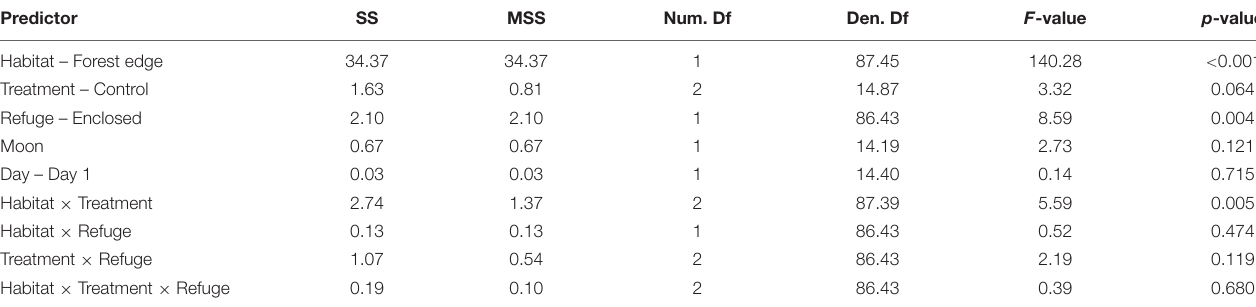
TABLE 1 | Model output showing the effects of habitat, refuge, risk treatment, moon illumination, and day on the amount of food eaten by white-footed mice. Predictor SS MSS Num. Df Den. Df